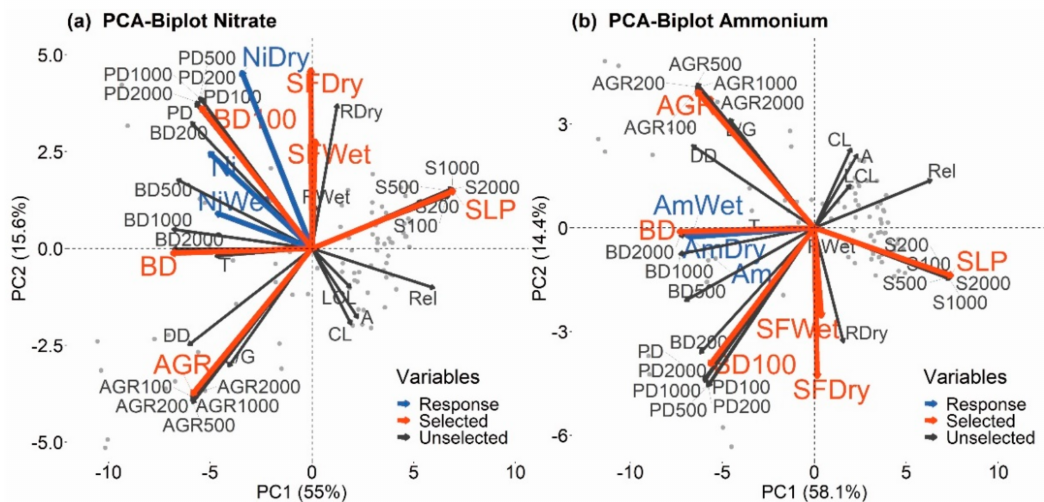
Figure 6. Principal components analysis of environmental variables for 43 catchments (gray dots) for NO 3 − ( a ) and NH 4 + export ( b ). Red-labeled variables are main components for PC1 and PC2. Blue-labeled variables indicate annual nitrate (Ni), dry season nitrate (NiDry) and wet season nitrate export (NiWet) in ( a ) and annual ammonium (Am), dry season ammonium (AmDry) and wet season ammonium export (AmWet) in ( b ).